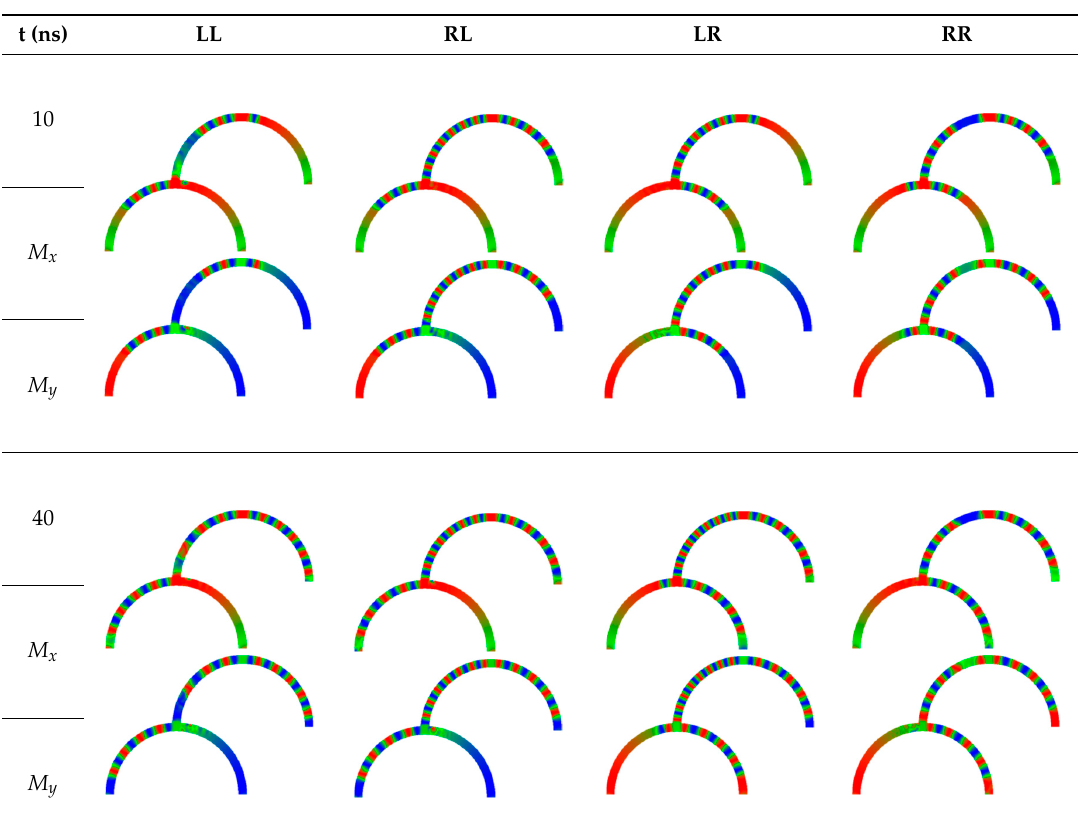
Table 1. Results of different rotational orientations at both inputs after 10 ns and 40 ns, respectively.